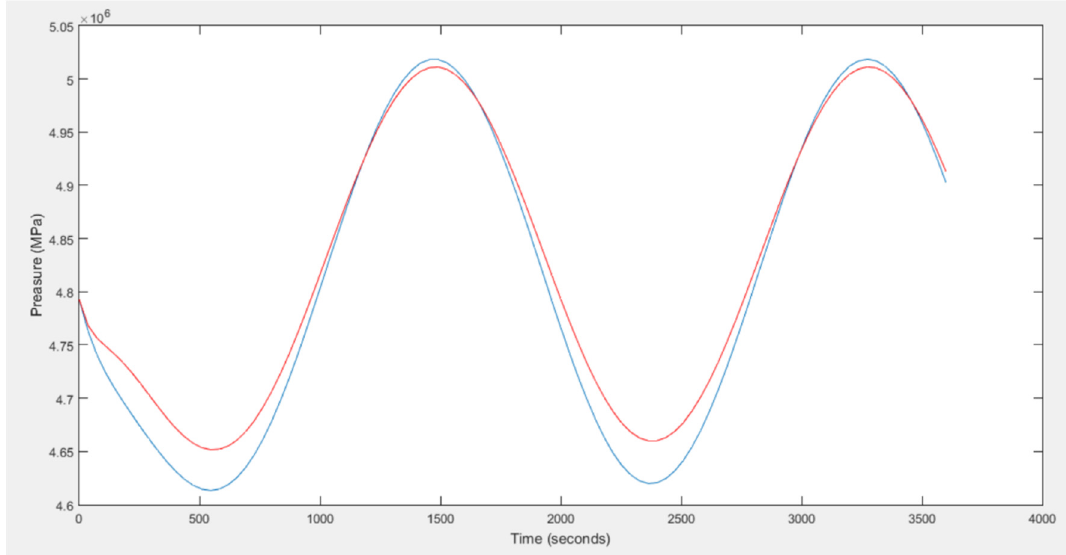
Figure 12. Length = 50 km, diameter = 1.0 m, mass flow = 240 kg/s. The parabolic model is plotted in red, while the hyperbolic model—in blue.